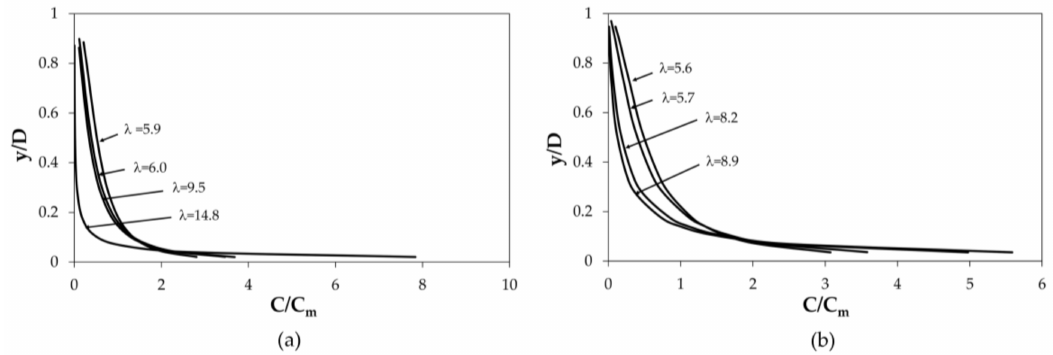
Figure 5. Relationship between parameter λ and concentration distribution degree of uniformity at constant values of M : ( a ) Valiani’s data at M = 12 and ( b ) Coleman’s data at M =